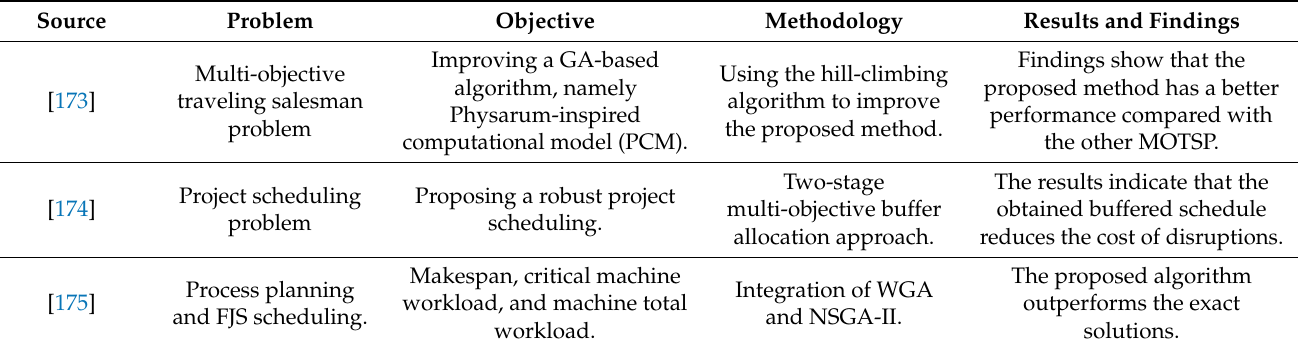
Table 5. Summary of the literature review on NSGA-II applications in different fields, along with methodology and results.